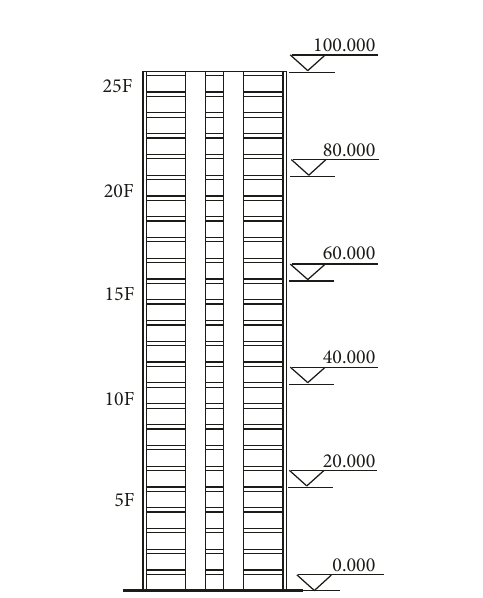
Figure 2: Structure